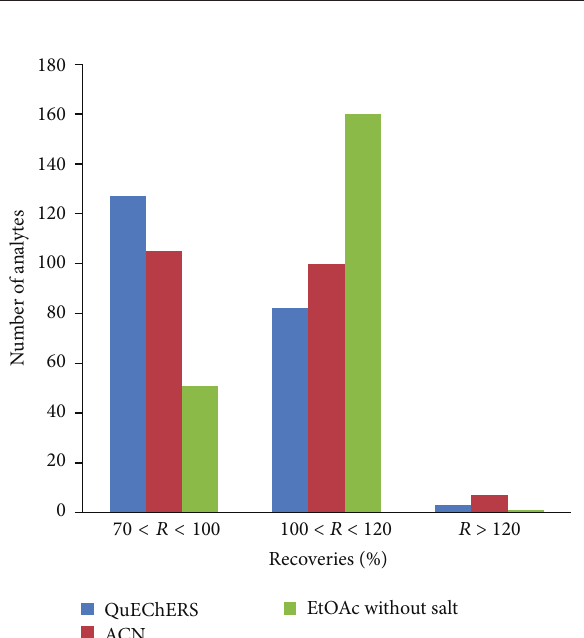
Figure 2: Recovery (%) data obtained using extraction procedures; QuEChERS, ACN, and EtOAc without